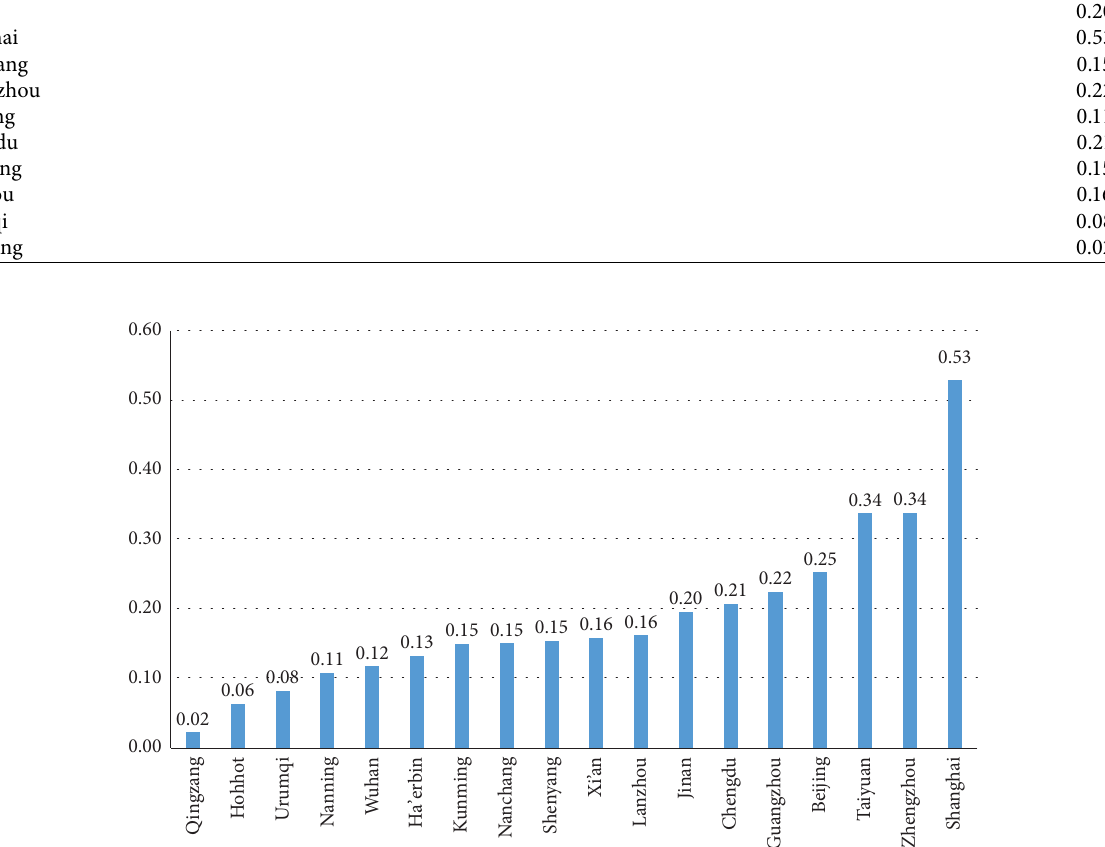
Figure 2: Comparison of performance evaluation results of 18 railway